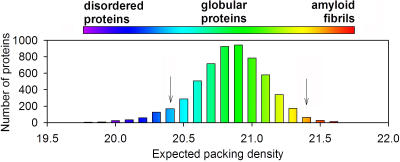
Histogram Representing the Distribution of 5,829 Globular Protein Domains (Database 80%) as a Function of the Expected Packing DensityArrows indicate upper and lower thresholds obtained from the ROC curves (see Figures 1 and 2) which correspond to unusually strong and unusually weak expected packing density.